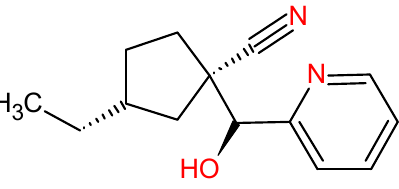
Figure 11. Promising molecule ZINC91881108 obtained after virtual screening.